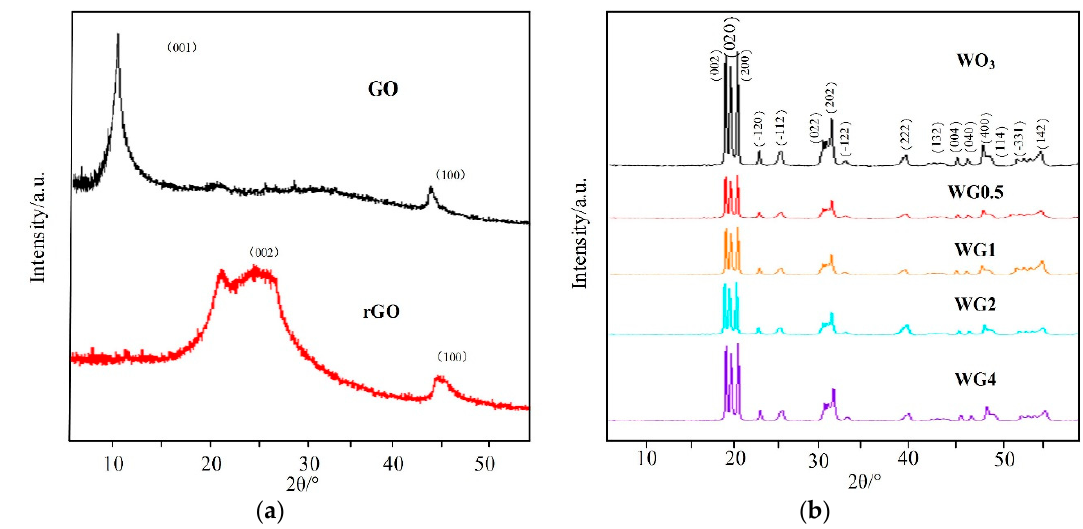
Figure 3. ( a ) A X-ray diffraction (XRD) patterns of graphite oxide (GO) and rGO; ( b ) XRD patterns of WO 3 and different concentrations of WO 3 /rGO nanocomposites.